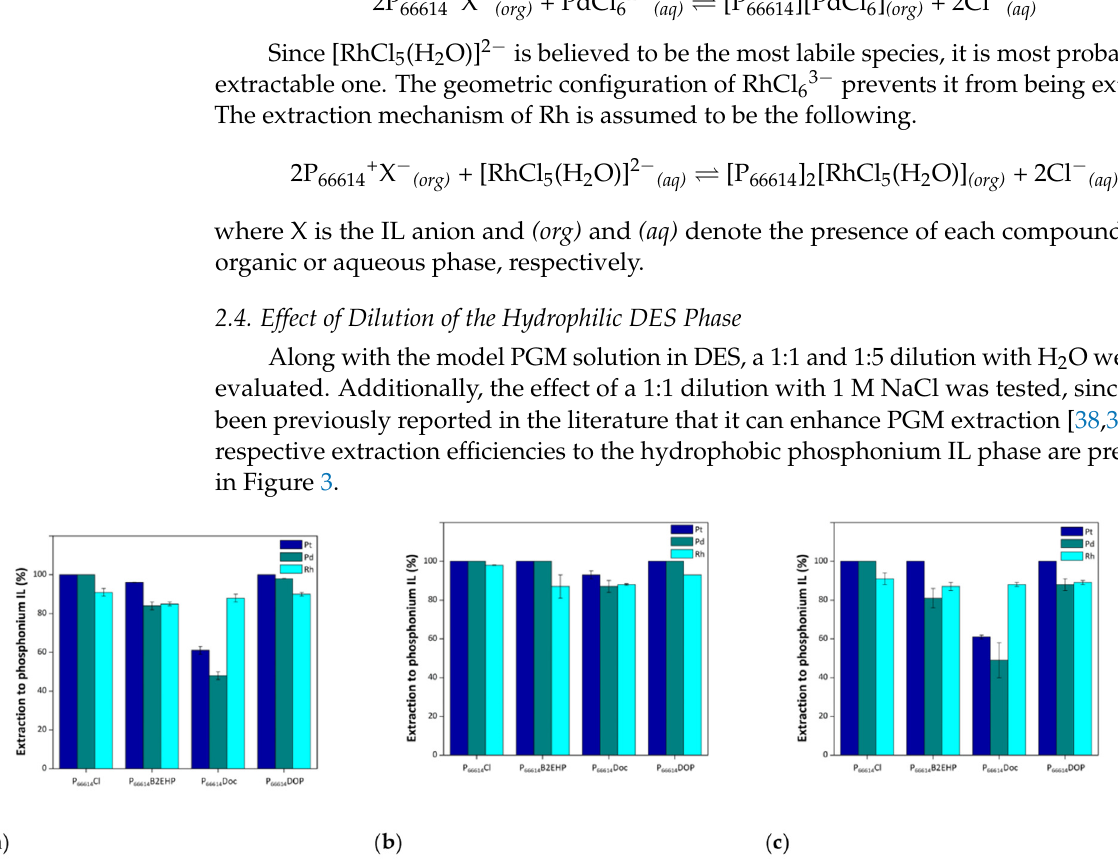
Figure 3. Extraction efficiencies (%) of PGMs from PGM model solution to phosphonium ILs with DES phase: ( a ) diluted 1:1 with H 2 O, ( b ) diluted 1:5 with H 2 O, and ( c ) diluted 1:5 NaCl.